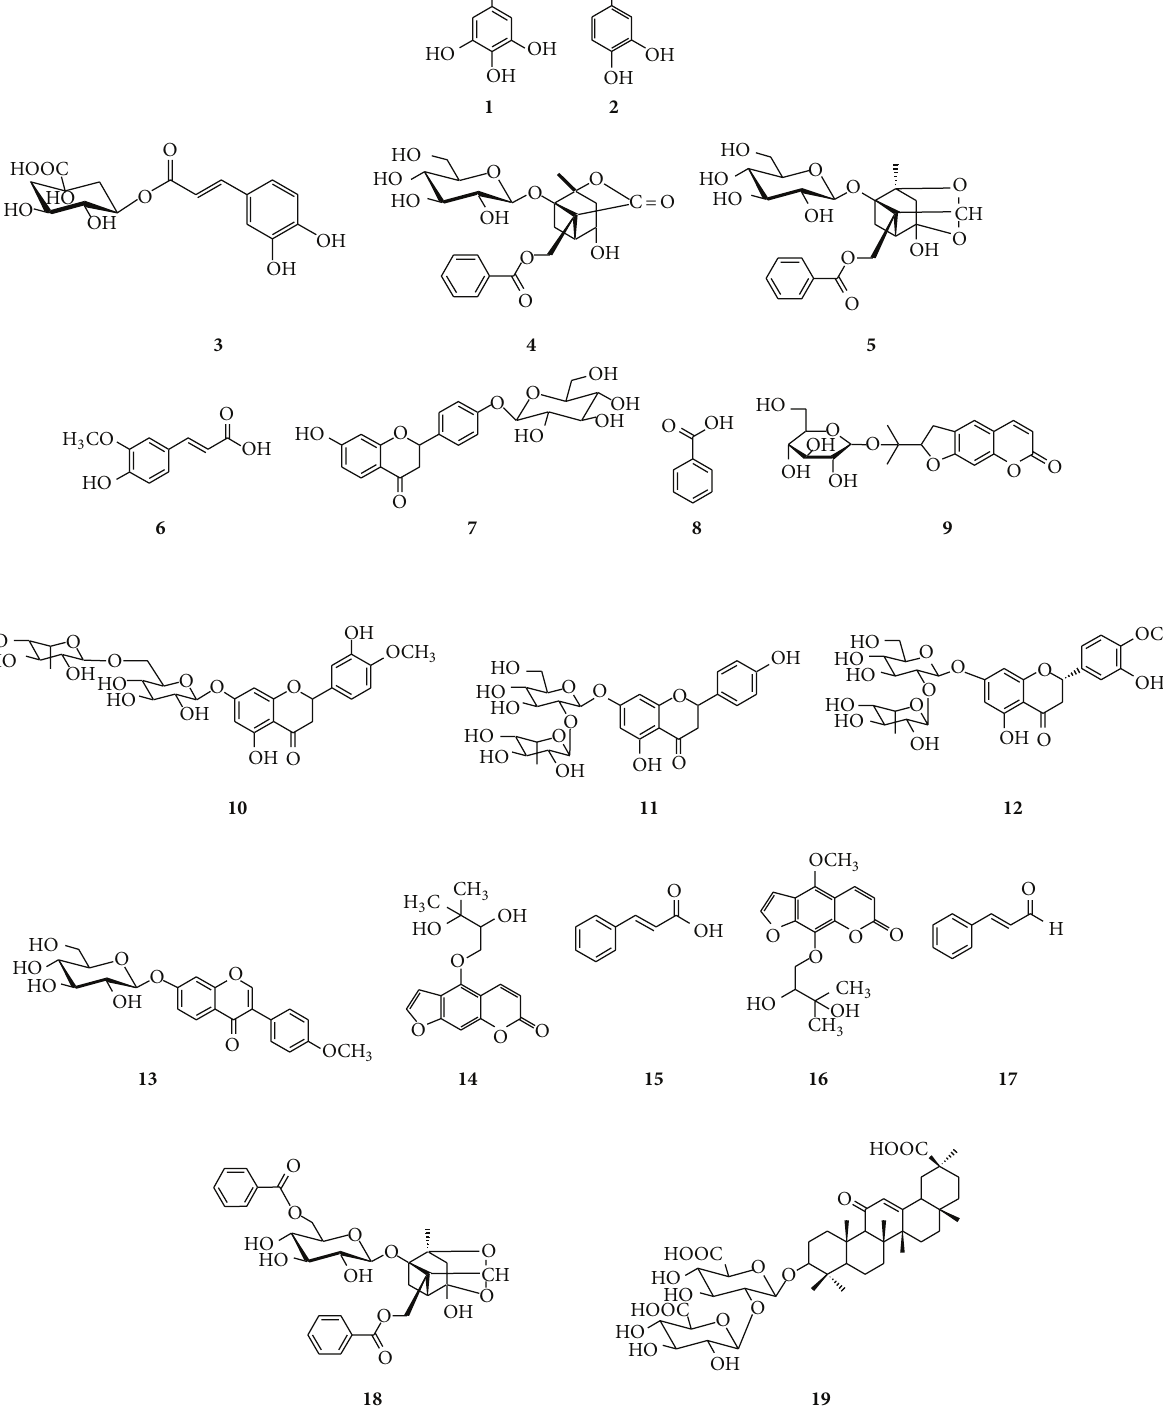
Figure 1: Chemical structures of 19 marker compounds in Ojeok-san (OJS). ( 1 ) Gallic acid, ( 2 ) protocatechuic acid, ( 3 ) chlorogenic acid, ( 4 ) albiflorin, ( 5 ) paeoniflorin, ( 6 ) ferulic acid, ( 7 ) liquiritin, ( 8 ) benzoic acid, ( 9 ) nodakenin, ( 10 ) hesperidin, ( 11 ) naringin, ( 12 ) neohesperidin, ( 13 ) ononin, ( 14 ) oxypeucedanin hydrate, ( 15 ) cinnamic acid, ( 16 ) byakangelicin, ( 17 ) cinnamaldehyde, ( 18 ) benzoylpaeoniflorin, and ( 19 )